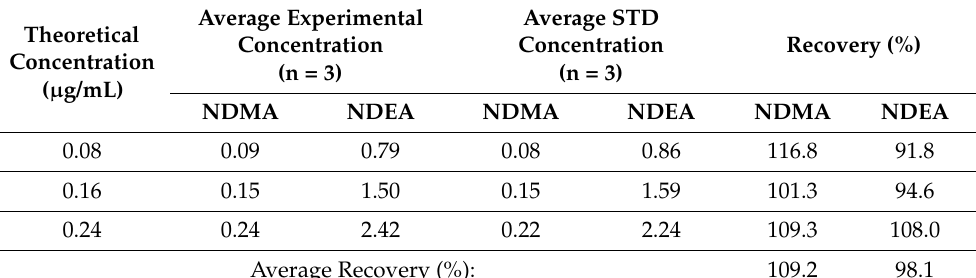
Table 2. Recoveries obtained from accuracy